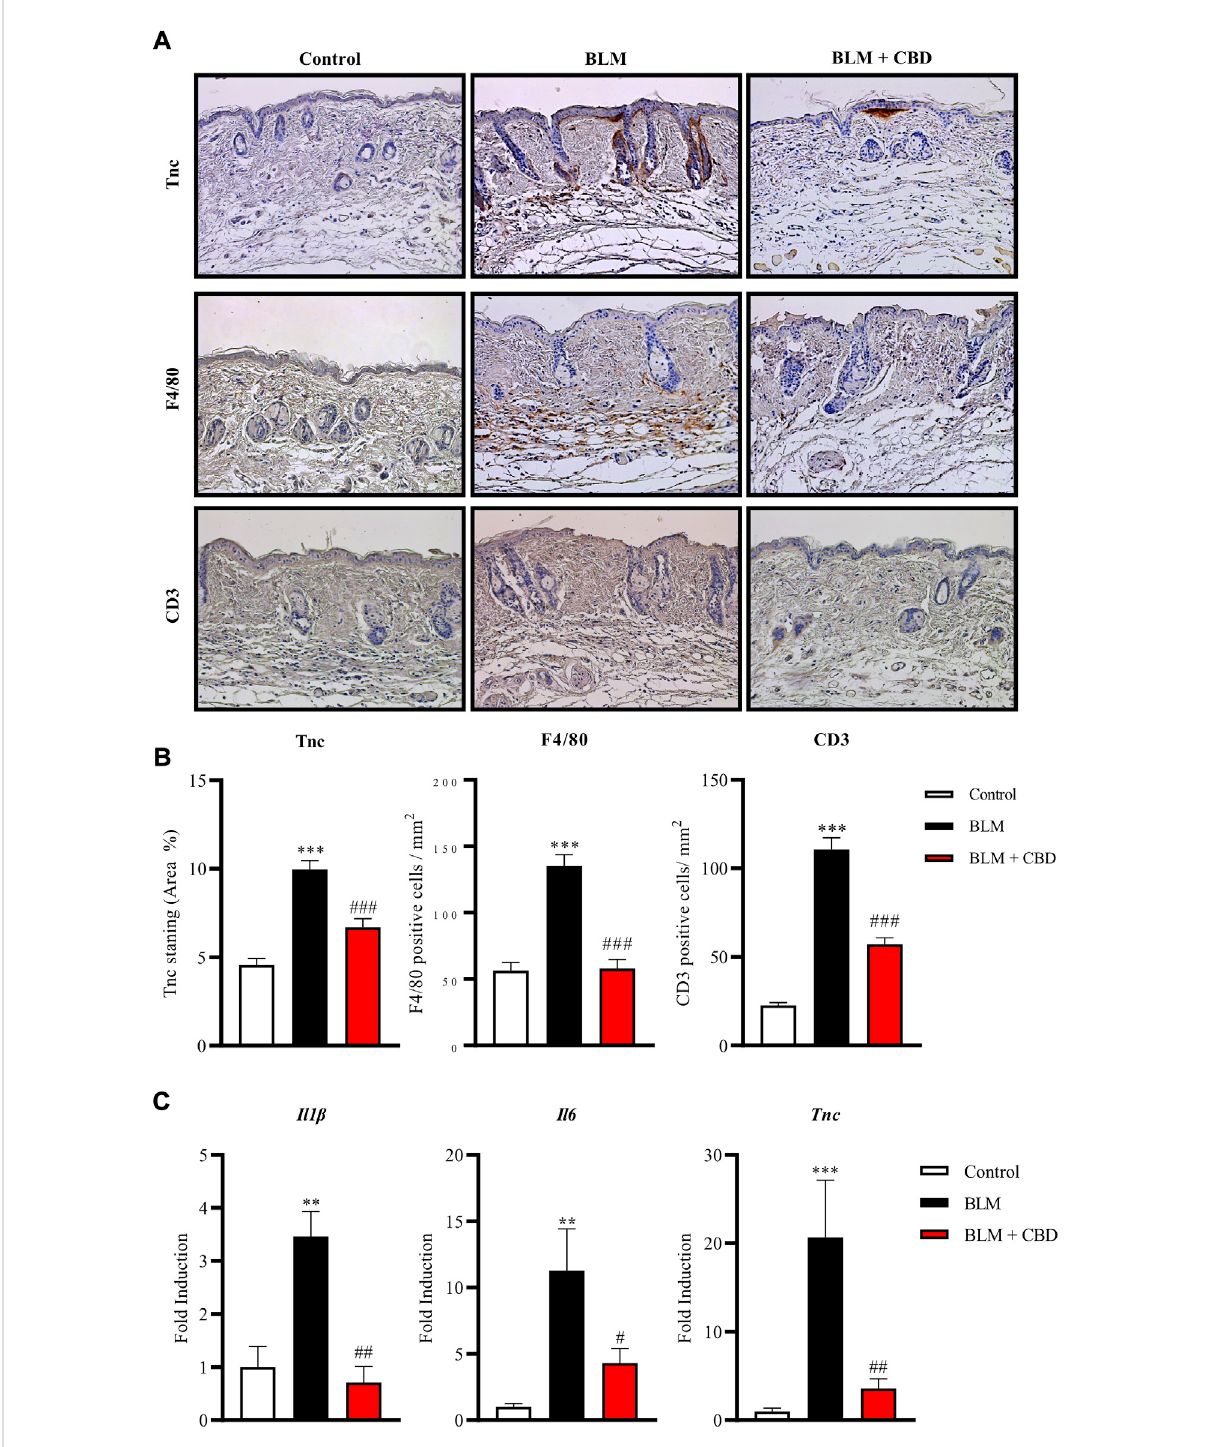
Treatment with CBD reduced skin fi brosis and in fl ammation in a mouse model of systemic sclerosis. (A) Representative images of Tnc, F4/ 80 and CD3 immunohistochemistry. (B) Quanti fi cations of Tnc, F4/80 and CD3 expression were performed with Image J software. Values are expressed as mean ± SEM. *** p < 0.001 vs control mice. # # # p < 0.001 vs BLM-treated mice. (C) Gene expression of in fl ammatory and fi brotic markers including Il-6 , Il-1 β and Tnc was signi fi cantly downregulated in CBD-treated mice compared with BLM mice. Data represent the mean ± SEM (n = four to six animals per group). ** p < 0.01; *** p < 0.001 vs control mice. # p < 0.05; # # p < 0.01 vs BLM-treated